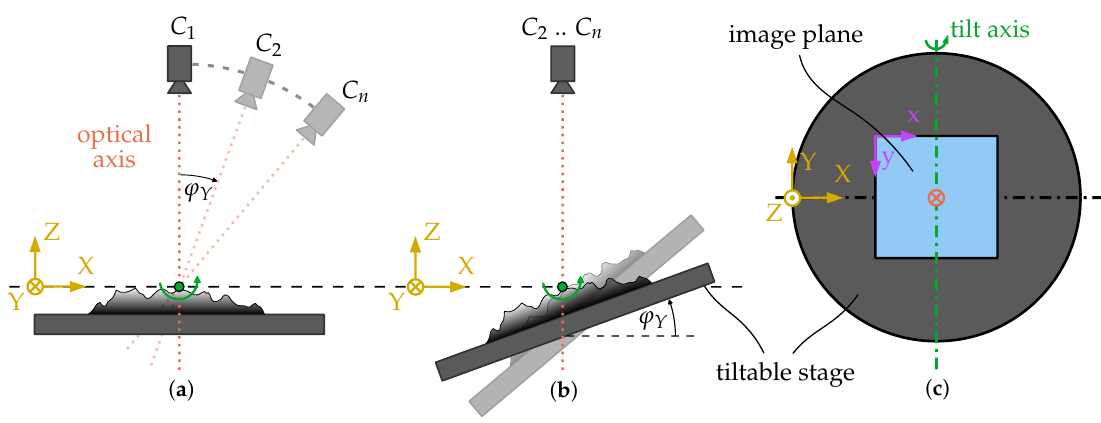
Figure 3. Equivalence of camera ( a ) and object motion ( b ) for a rotation angle ϕ Y ; ( b ) Eucentric tilting process with fixed eucentric point (green); ( c ) Adjustment of the scan rotation leading to the parallelism of the tilt axis and the image’s y